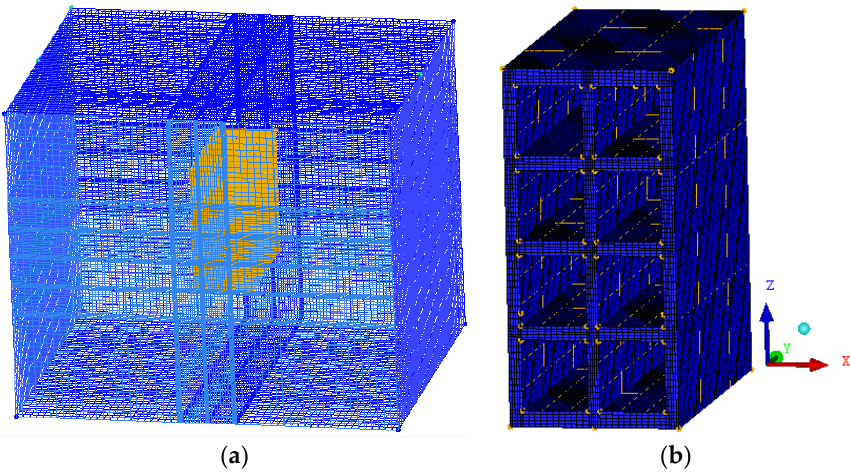
Figure 3. Mesh of the ( a ) full domain and ( b ) brick.